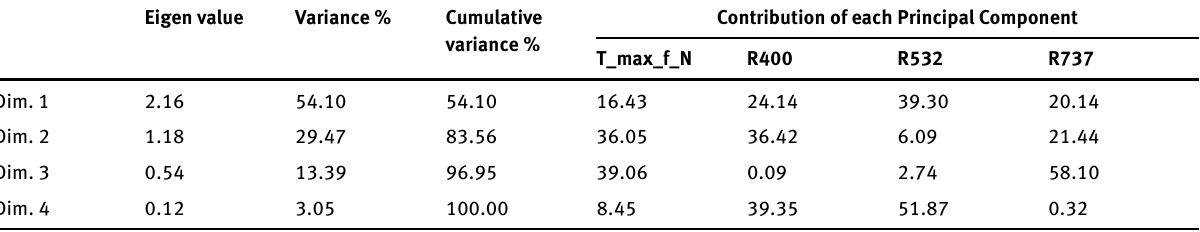
Table 3: Variance explained by the principal component analysis and the contribution of each principal component (Dim.) for cultivar Touriga Franca (TF), as well as the contribution of each variable to the principal component, when the selected variables for cultivar Touriga Nacional (TN) were tested in TF data